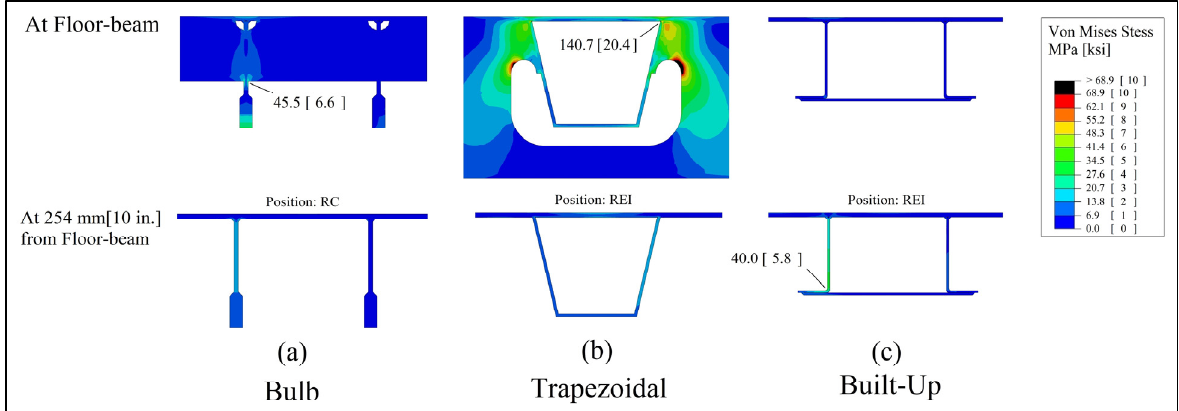
Figure 22. Von Mises stress distribution in continuum case 4.